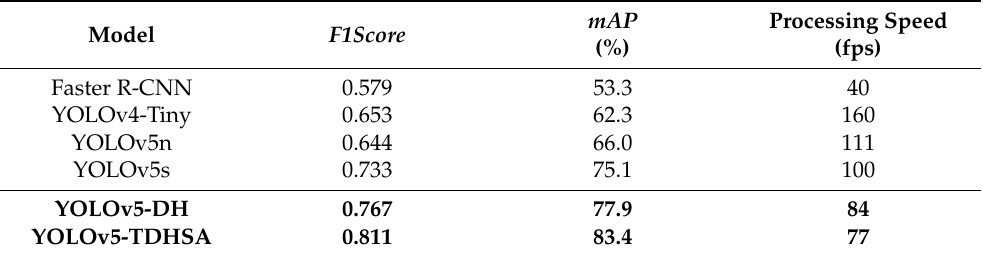
Table 11. Results of compared models on TT100K dataset.